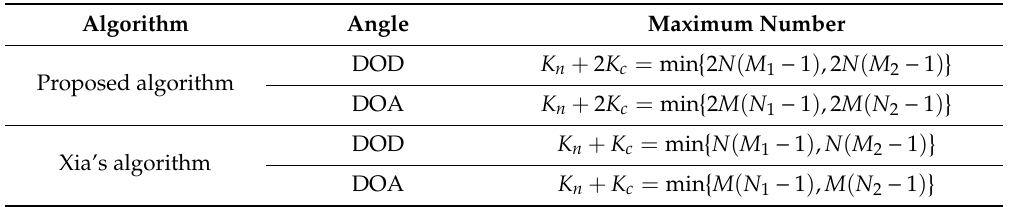
Table 2. Maximum number of detection